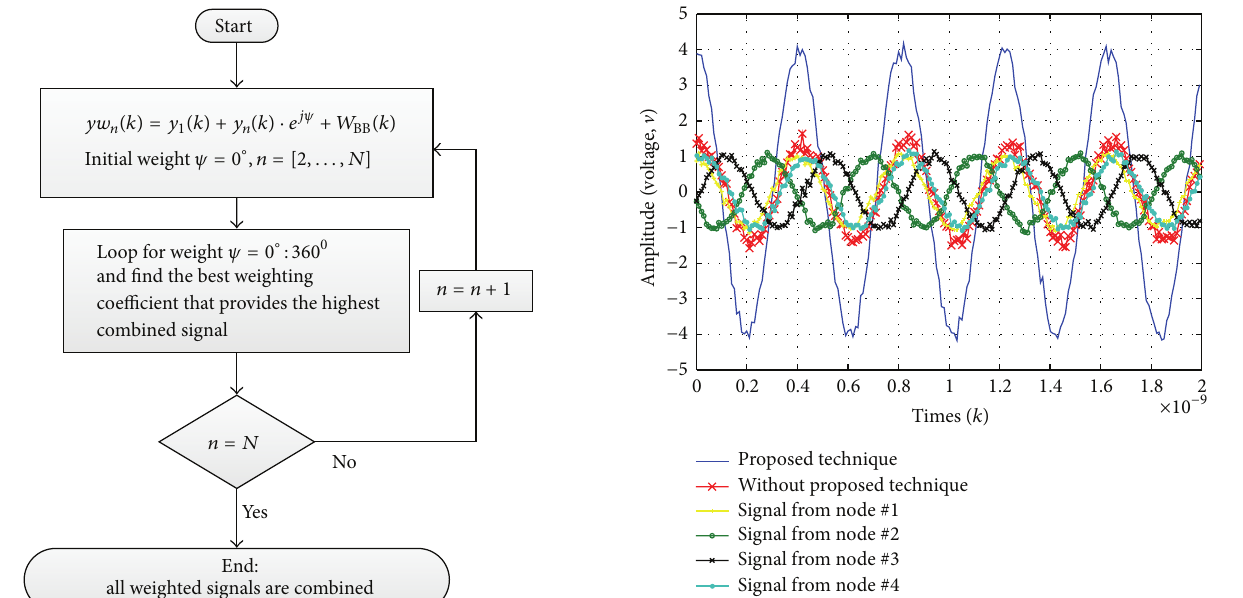
Figure 6: Summary flow chart of proposed phase synchronization.